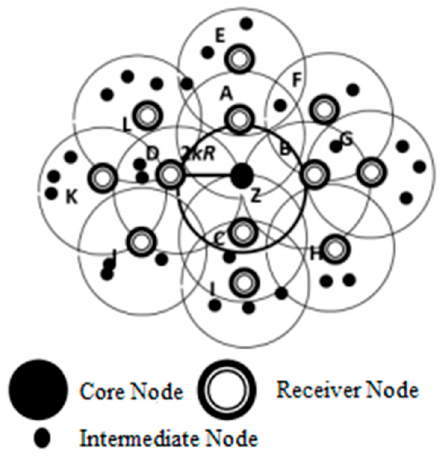
Figure 5. Density of Clusters with 2kR Distance [4].